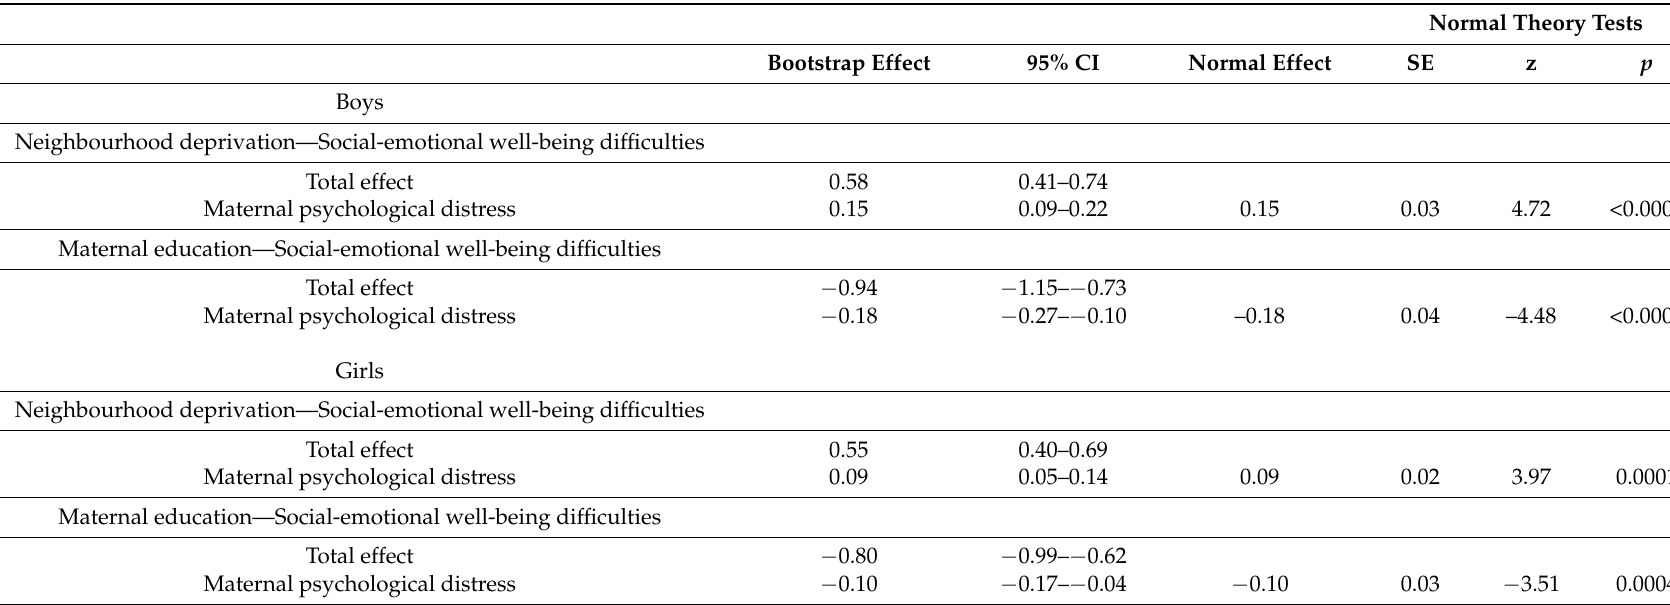
Table 3. Indirect effects of neighborhood deprivation and maternal education on child social-emotional well-being difficulties through maternal psychological distress by gender ( n =